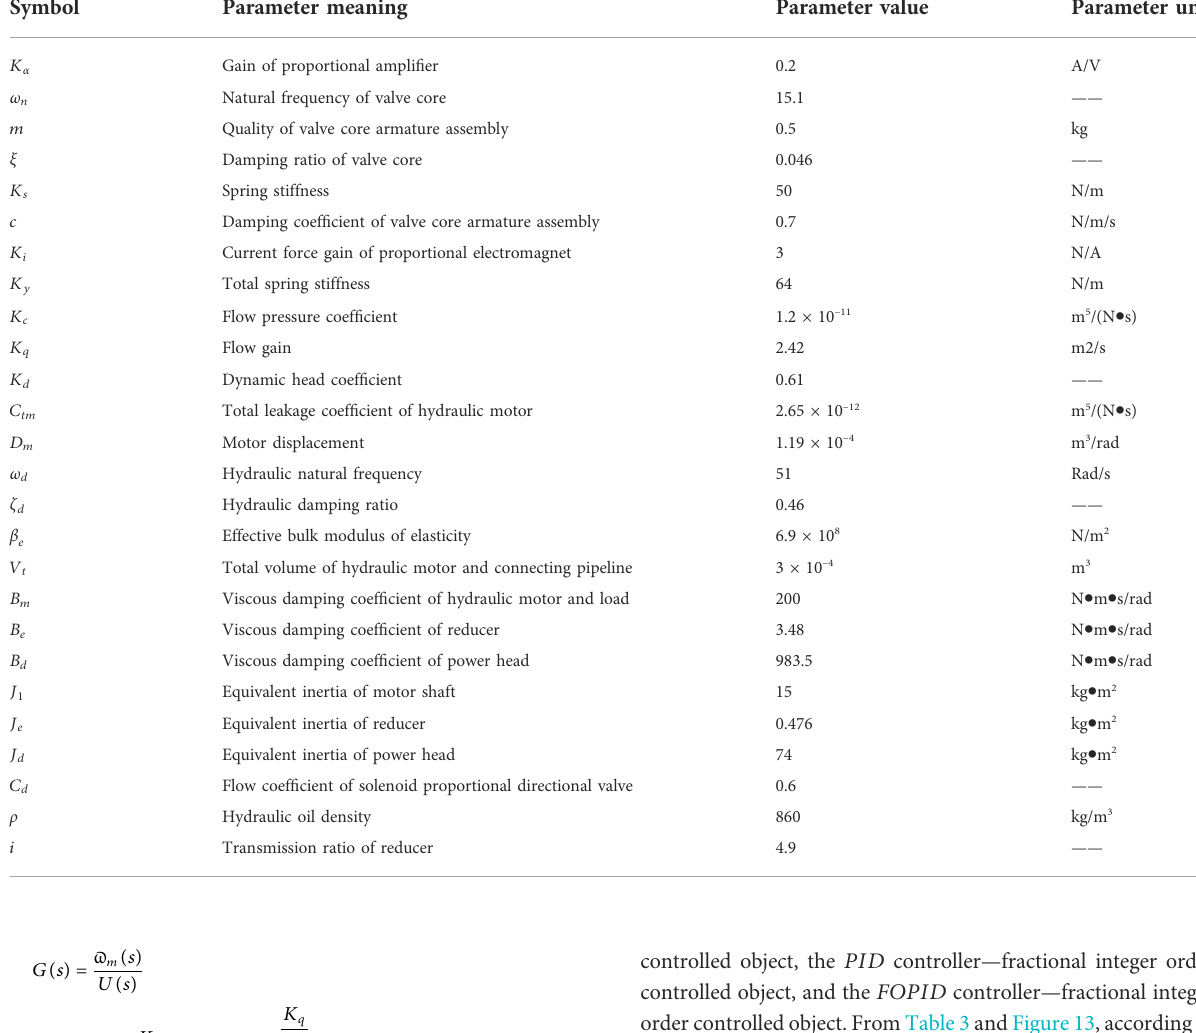
TABLE 2 Mathematical modeling parameter table of the fractional integer order of the hydraulic